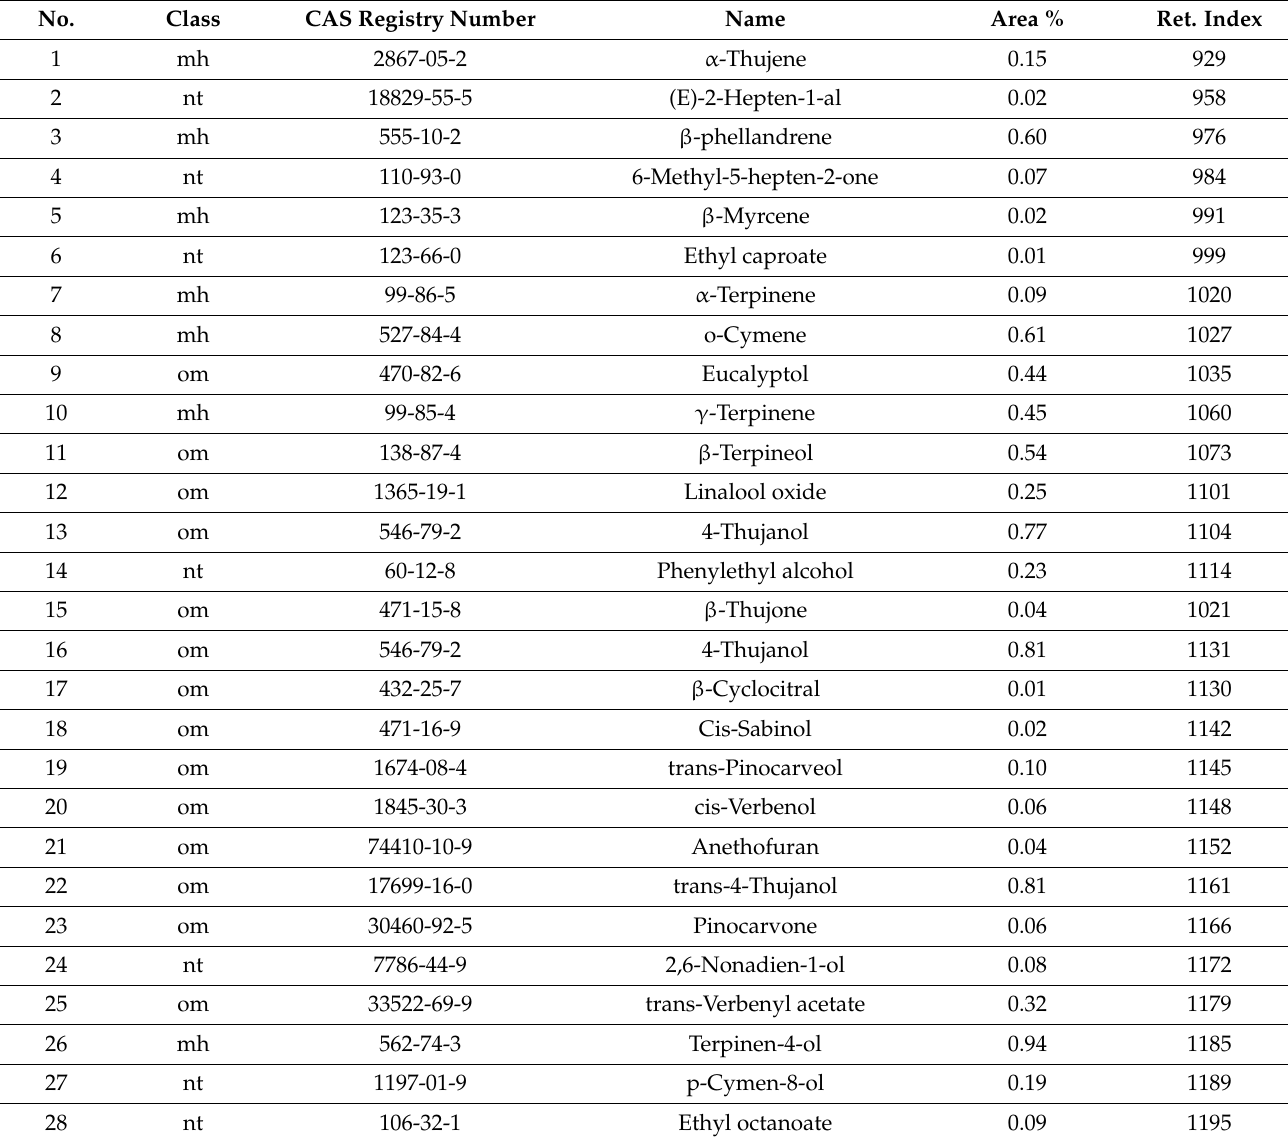
Table 1. GC-MS analysis of the ethanolic extract of C. gileadensis